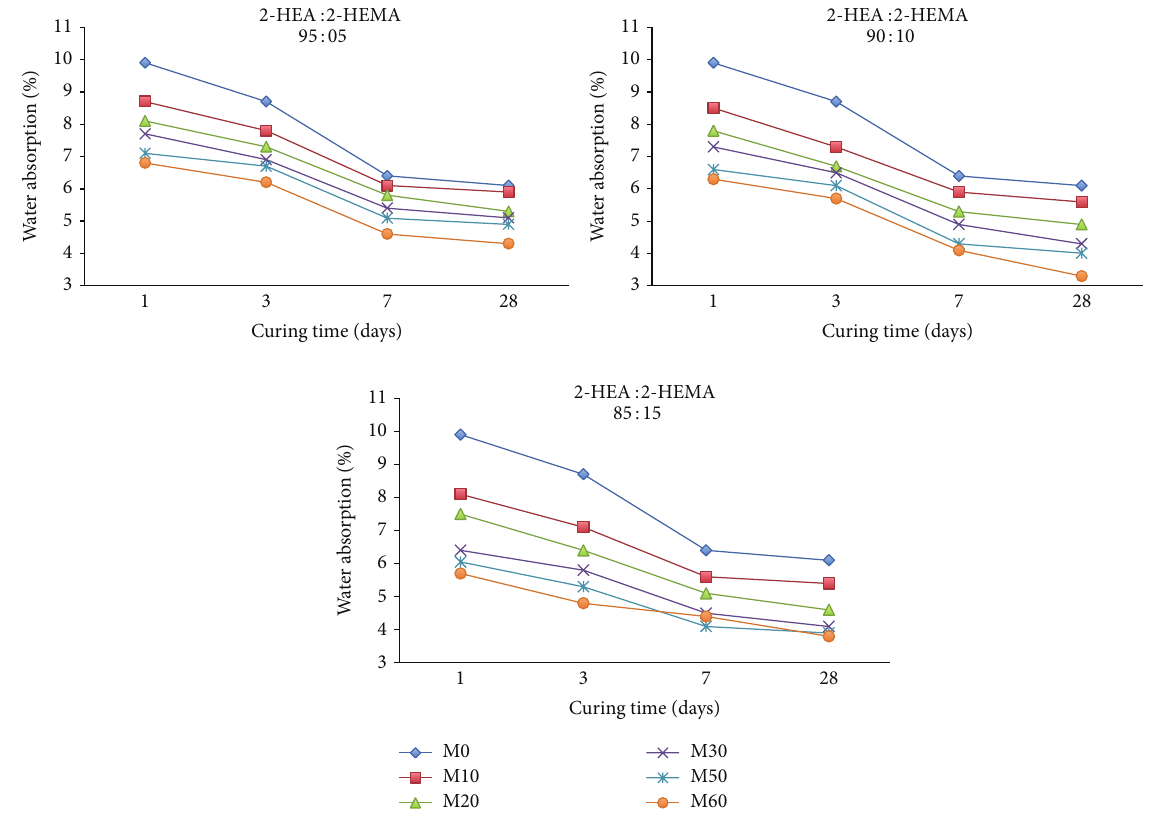
Figure 6: The effect of FA on water absorption of mortar mixes in presence of latexes.